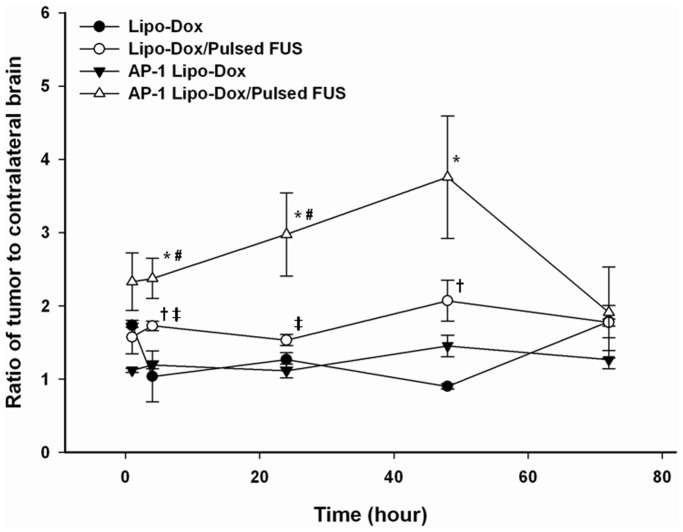
Pharmacokinetics of the 111In-doxorubicin liposomes in GBM-bearing mice determined by micro-SPECT/CT.Tumor-to-contralateral brain ratios for 111In-doxorubicin liposomes in the GBM-bearing mice were derived from the dynamic micro-SPECT/CT images after intravenous injection followed by sonication or nonsonication. * and # denote a significant difference compared with AP-1 Lipo-Dox and Lipo-Dox plus FUS, respectively (* and #, p<0.05). + and ‡ denote a significant difference compared with Lipo-Dox and AP-1 Lipo-Dox, respectively (+ and ‡, p<0.05).